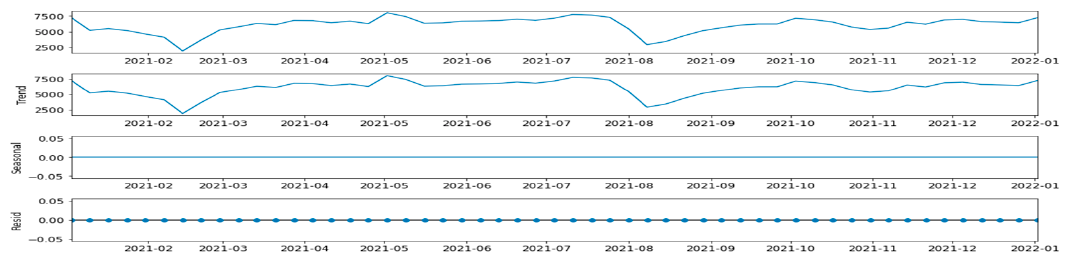
Figure 7. The weekly series decomposed plot.